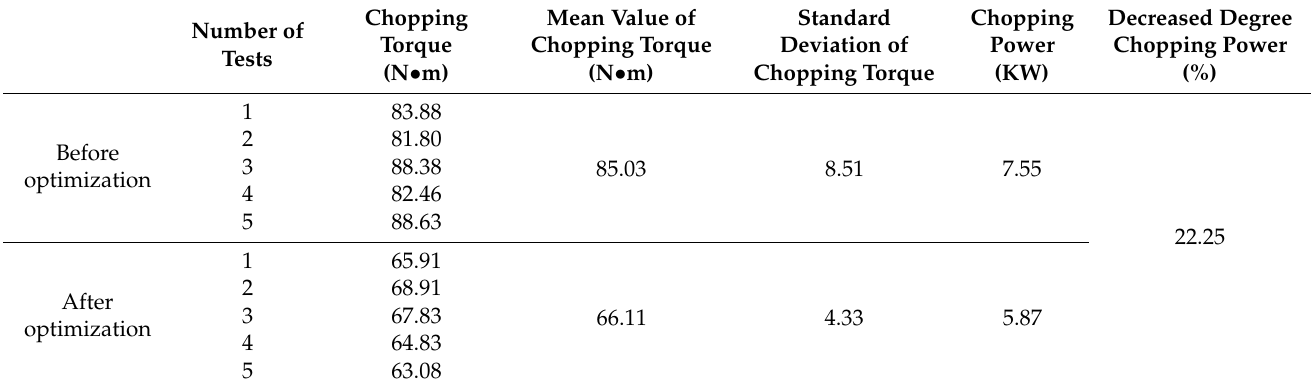
Table 4. Experimental data and analysis of chopping